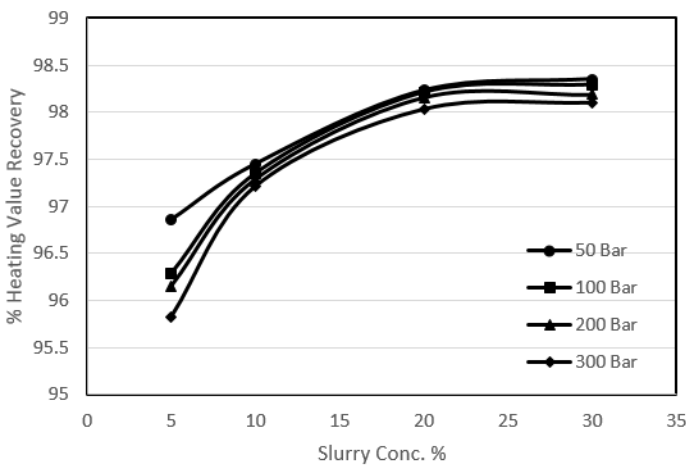
Figure 9. Effect of coal slurry concentration on heating value recovery.